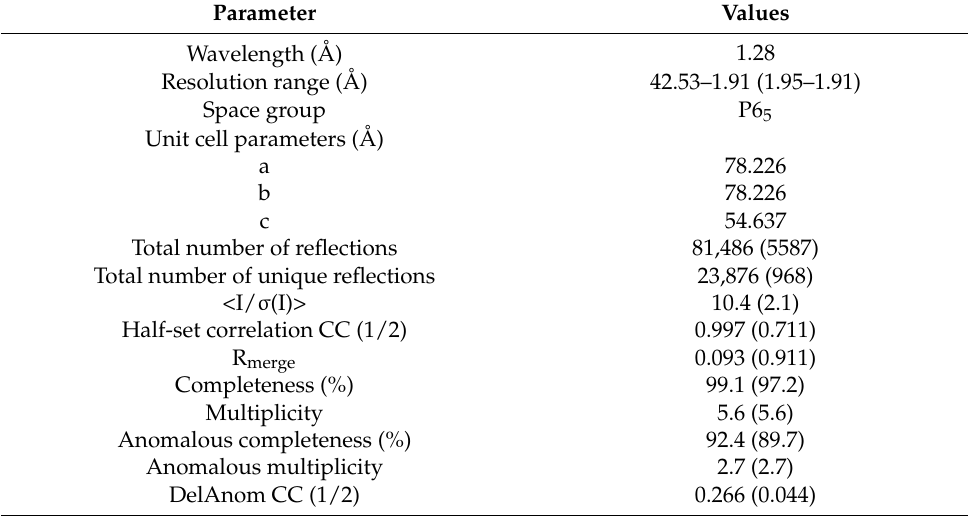
Table 1. Diffraction data statistics of crystals obtained from co-crystallization of Atox1 and ZnSO 4 in 1:1 ratio (PDB code 7ZC3). Values related to the outer high-resolution shell are in